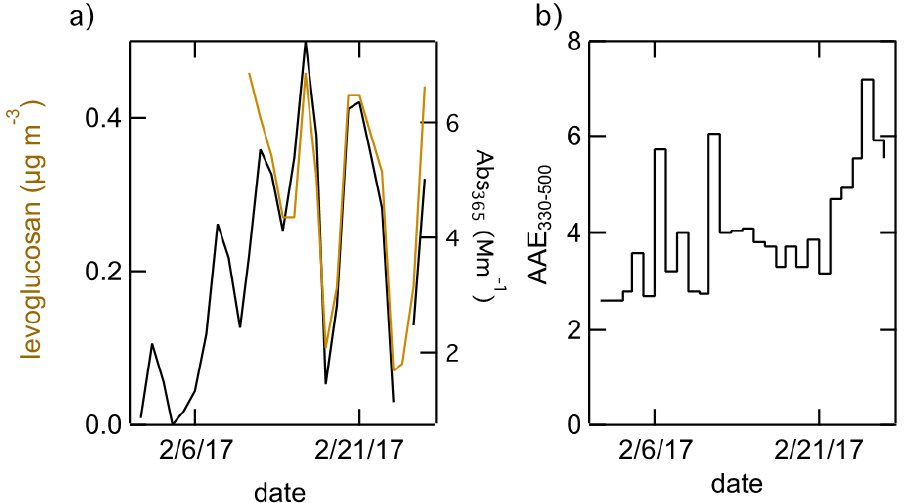
Figure 5. Time trend of levoglucosan concentration together with BrC absorption coefficient at 365 nm (panel ( a )); AAE 330 − 500 time trend (panel ( b